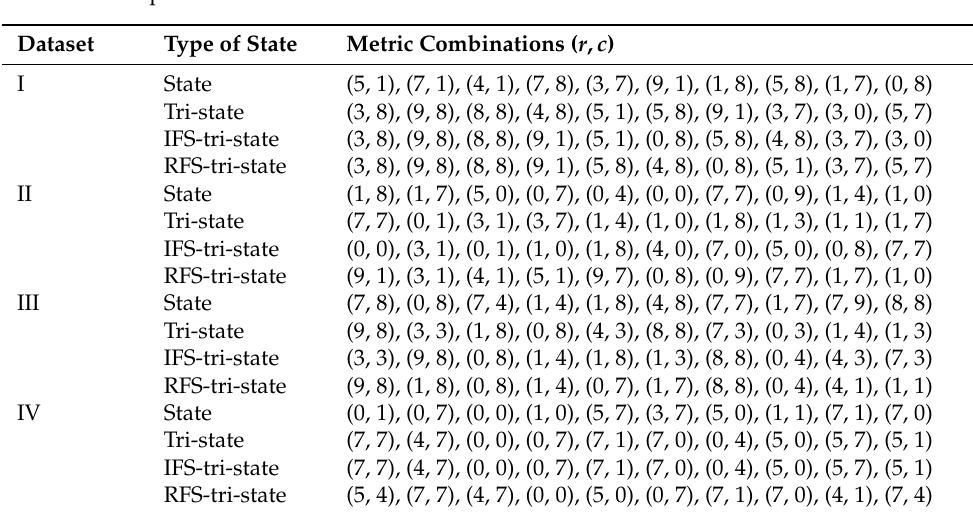
Table 8. The top 10 metric combinations for